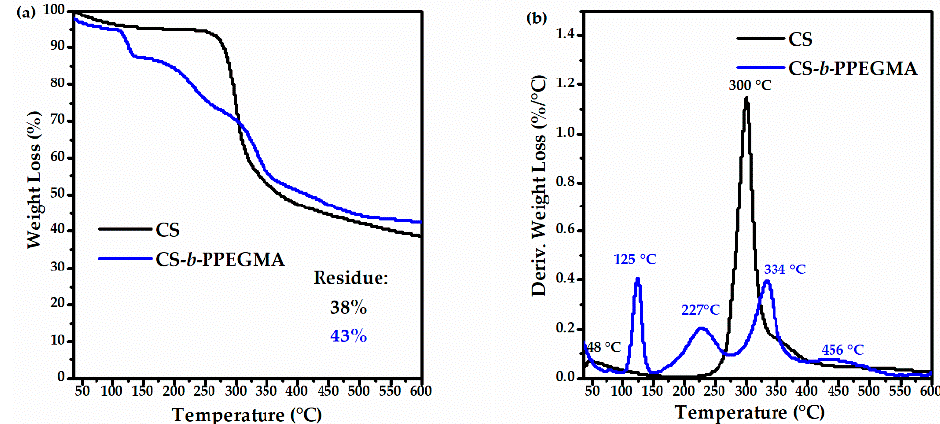
Figure 6. Thermograms of CS and CS- b -PPEGMA: ( a ) TG-thermogram and ( b ) DTG-thermogram.